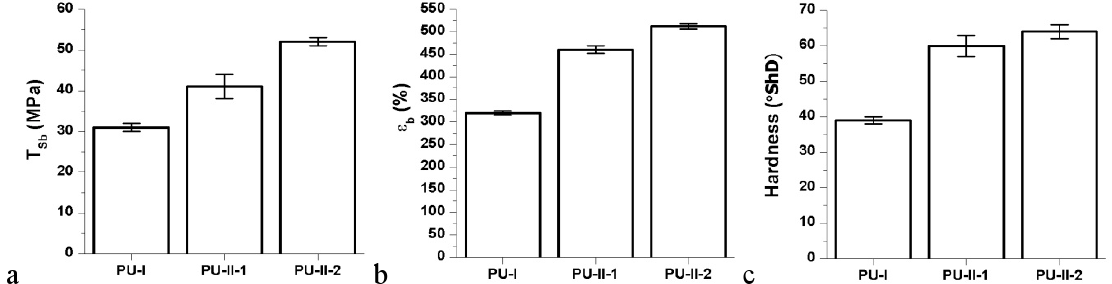
Figure 3. Tensile strength (T Sb ) ( a ), percent of elongation at break (%) ( ε b ) ( b ); and hardness ( c ) of obtained non-crosslinked and PVA-crosslinked PURs.